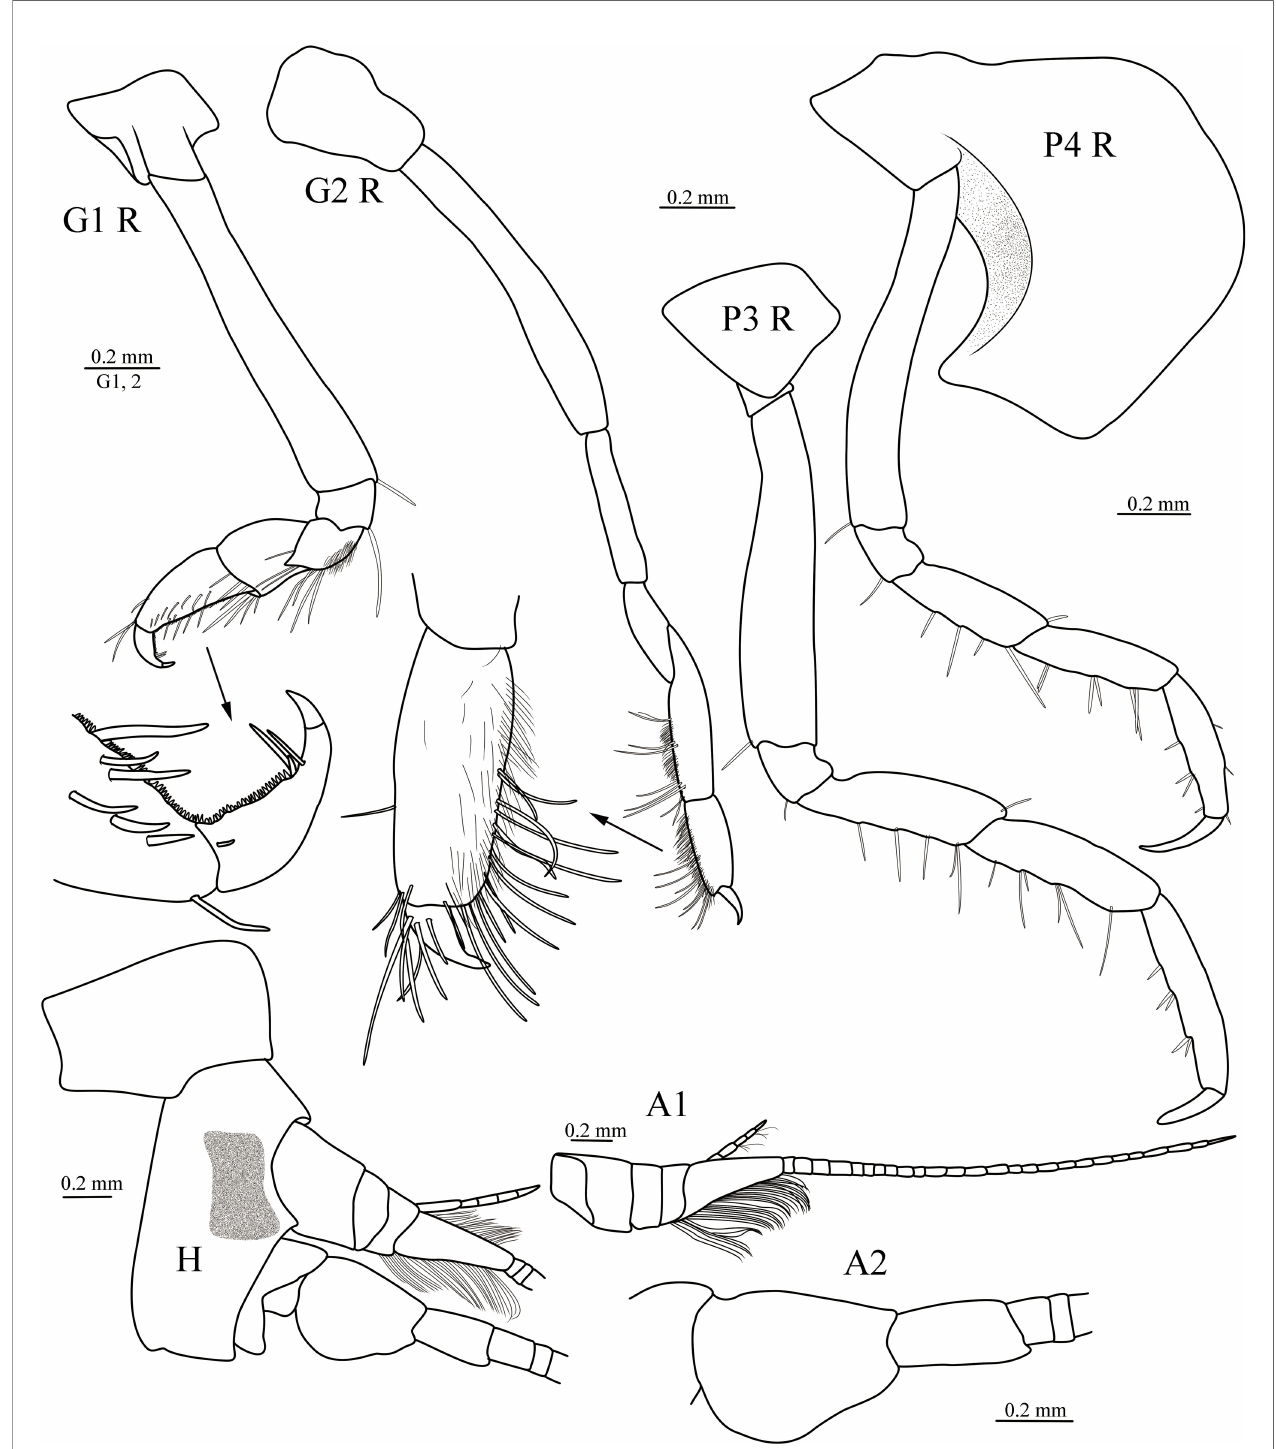
FIGURE 2 | Cyphocaris lubrica sp. nov., MBM 286819, male holotype (9.1 mm), showing head, antenna 1 and 2, gnathopod 1 and 2 and pereopod 3 and 4. For abbreviations, see